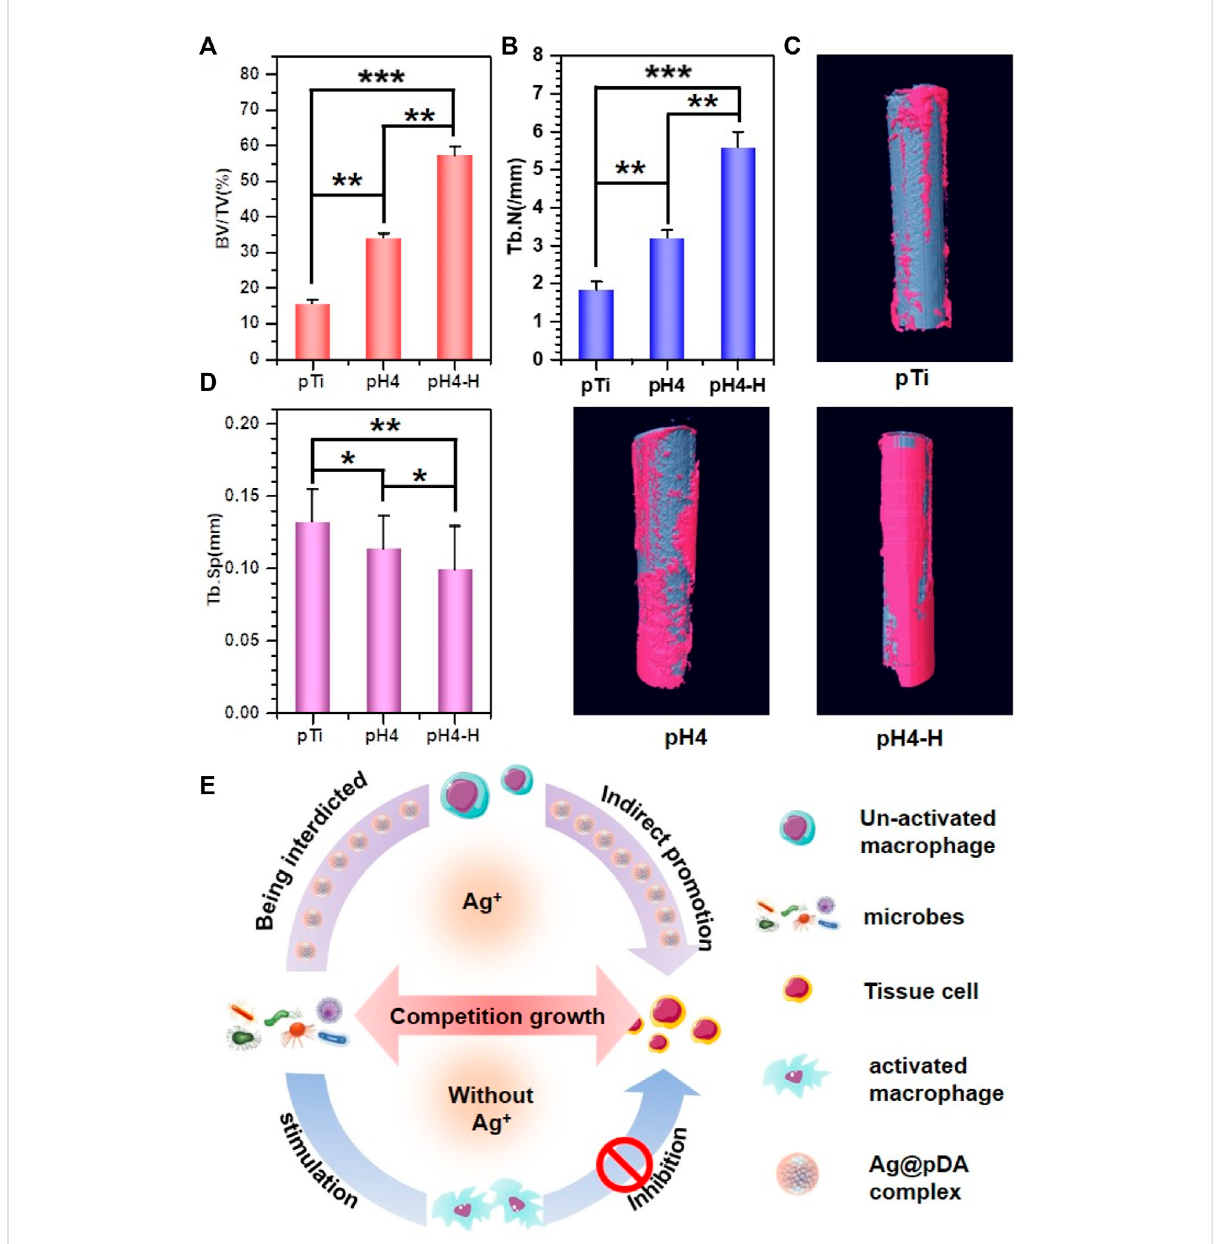
FIGURE 8 3Dmicro-CTmodelingofvarioussamples: (A – C) Quantitativeevaluationofnewbonesurroundingtheimplantsonthebasisofthepercentage of bone volume to tissue volume (BV/TV) (A) , Tb.N (B) and Tb.SP (C) value. (D) 3D micro-CT reconstructed images; (E) schematic illustration of induced-osteogenesis hypothesis. Data were expressed as the mean ± SD, n = 3. Statistically signi fi cant differences are indicated by * p < 0.05, ** p < 0.01 or *** p <